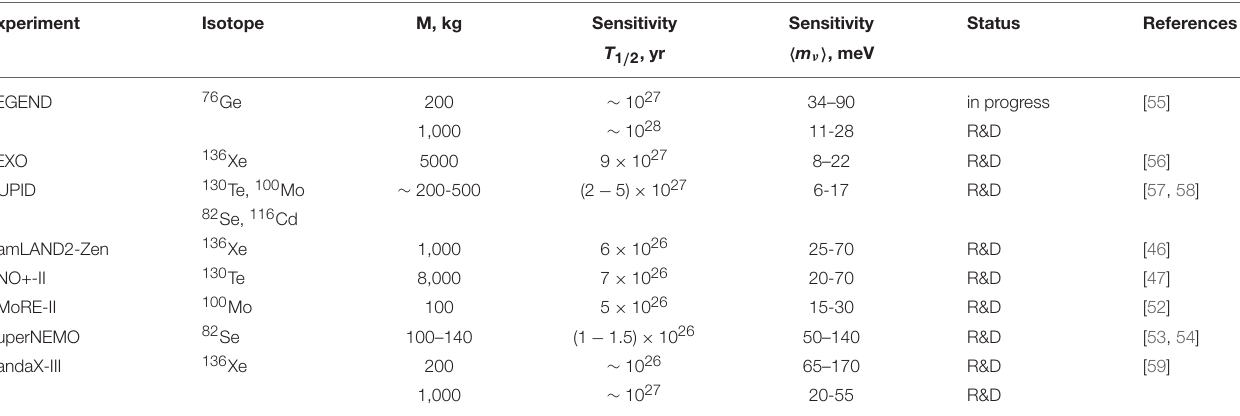
TABLE 3 | Main most developed and promising projects for next generation experiments. Experiment